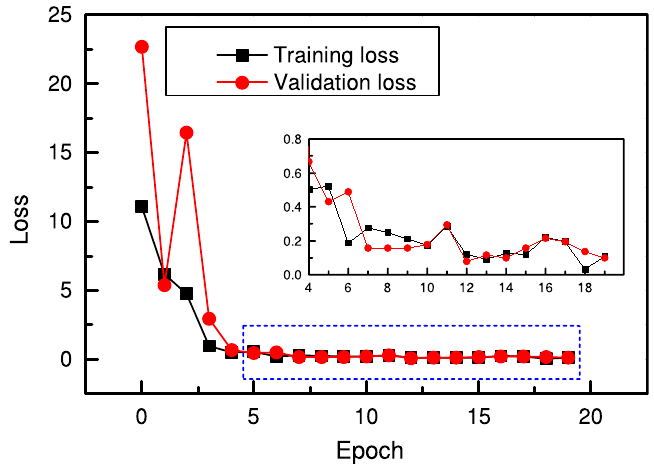
Figure 15. Training loss and validation loss for RUL prediction in the search phase.